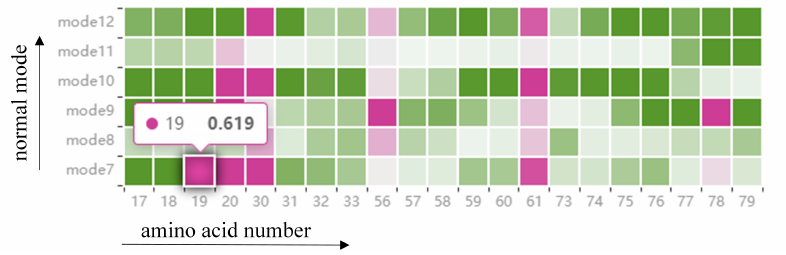
Figure 5. The HeatMap shows the fluctuation of amino acids around the cavity. Each grid in the HeatMap represents the displacement of the cavity-lining amino acids, encoded by color. Pink means that the amino acid is present around the cavity, and green means that it is not present around the cavity, where the shade of color represents the level of fluctuation of the amino